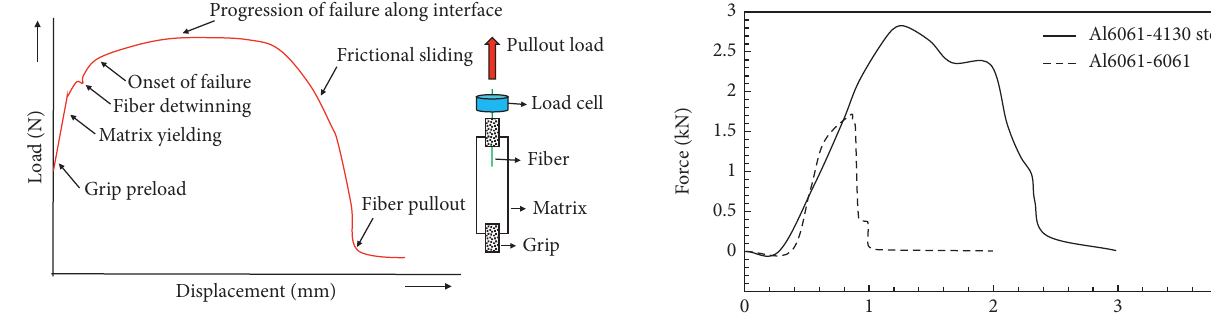
Figure 10: Typical pull-out force-displacement curve of UAM as- built (redrawn from [17]). Figure